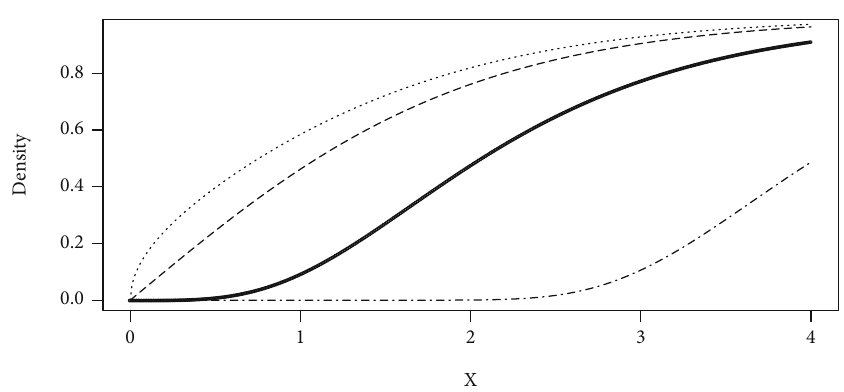
Figure 1: PDF plot of exponentiated standardized half logistic distribution.